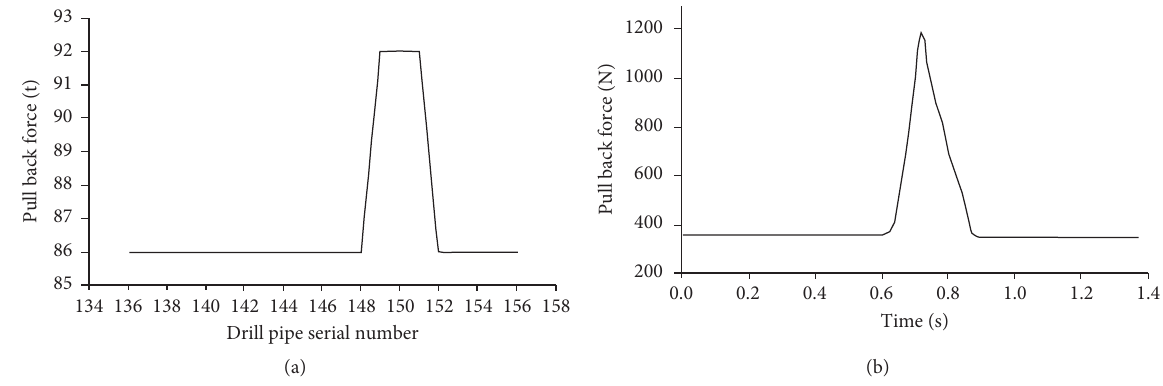
Figure 4: Comparison of engineering value and calculation result.